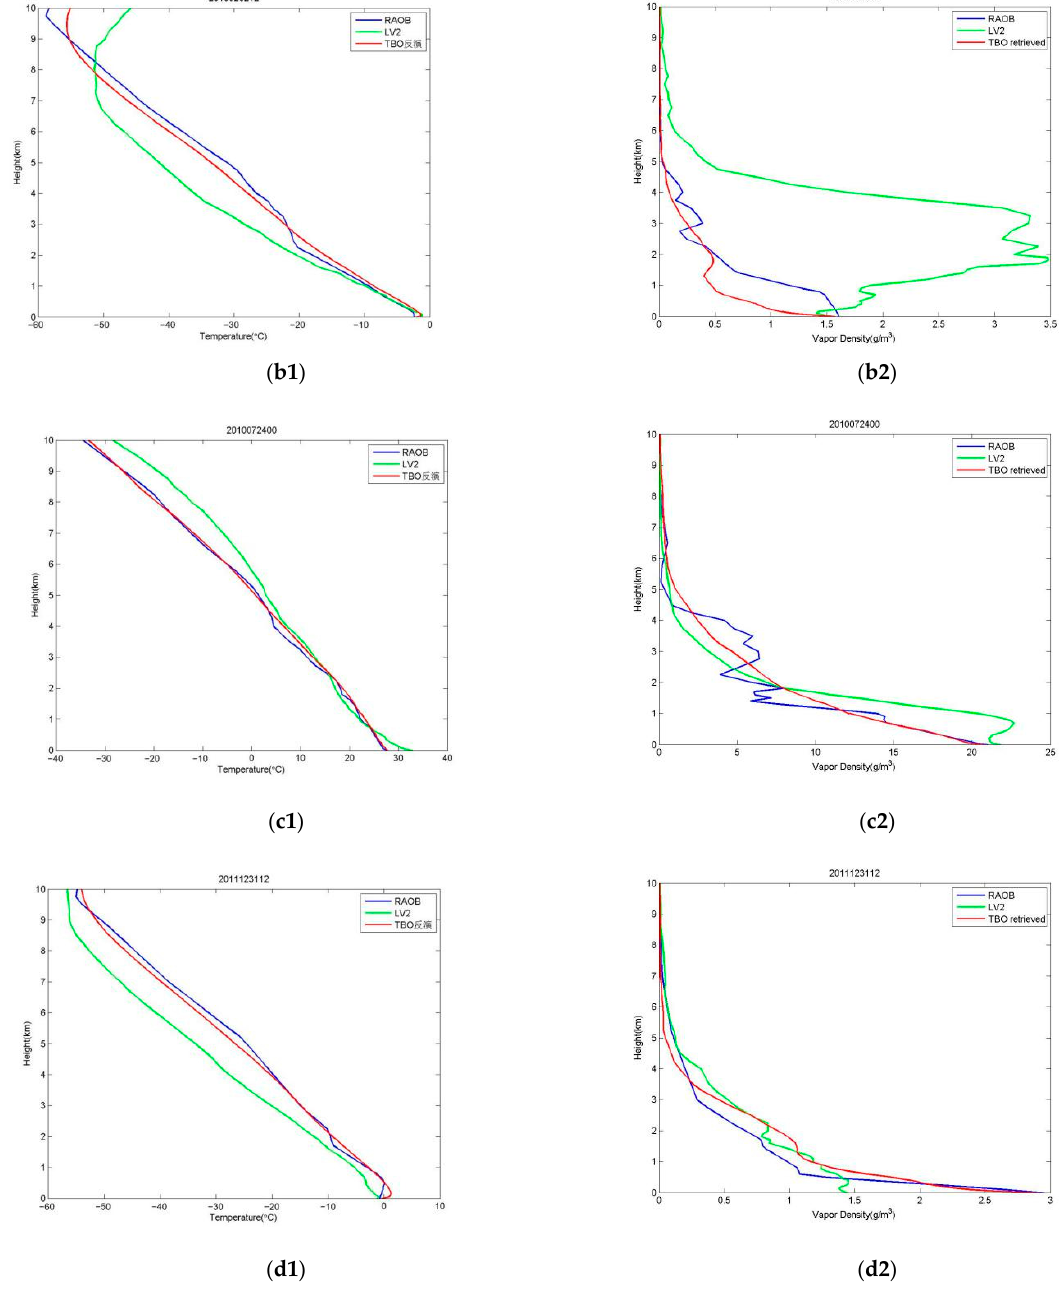
Figure 2. Four typical cases for comparison between the retrieved temperature and humidity profiles with RAOB. Blue lines for RAOB; green lines for LV2; and red lines for ˆ f − TB O . ( a1 ) Case 1: 2010011800 temperature; ( a2 ) Case 1: 2010011800 water vapor density; ( b1 ) Case 2: 2010020212 temperature; ( b2 ) Case 2: 2010020212 water vapor density; ( c1 ) Case 3: 2010072400 Temperature; ( c2 ) Case 3: 2010072400 water vapor density; ( d1 ) Case 4: 2011123112 temperature; ( d2 ) Case 4: 2011123112 water vapor density.